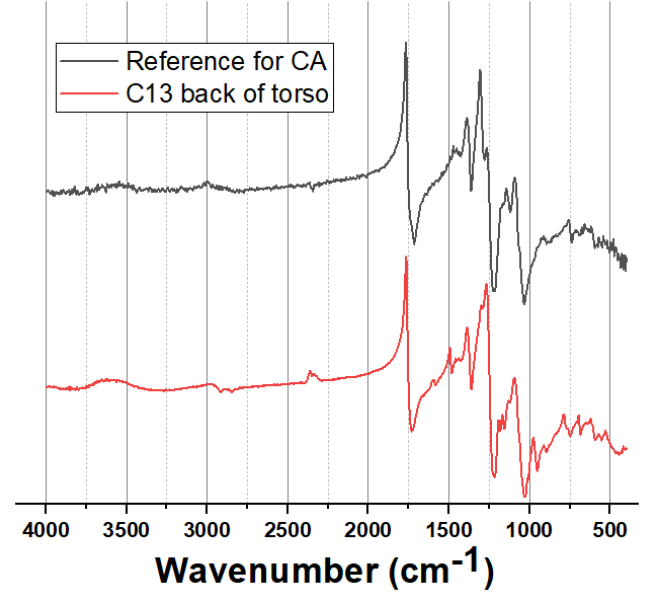
Figure 3. Typical ER-FTIR spectrum for CA dolls, illustrating the obtained spectrum for doll C13 (back of torso) and a reference spectrum for CA.